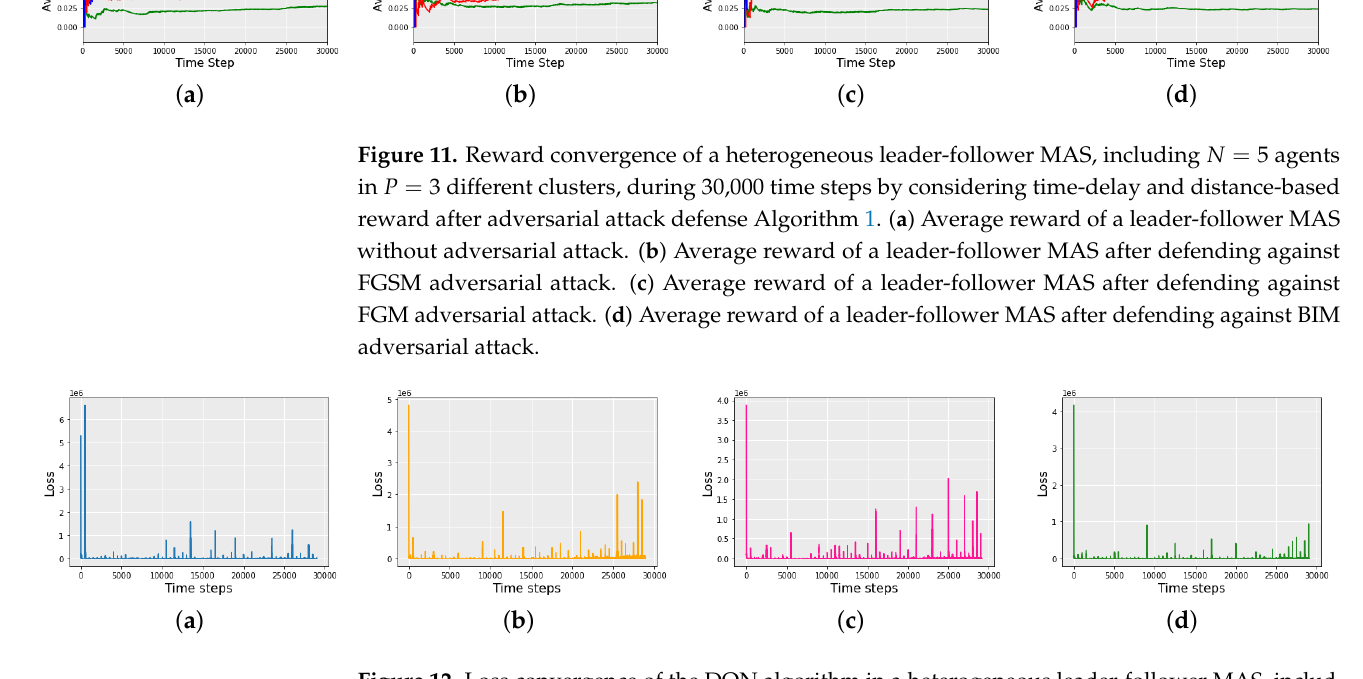
Figure 12. Loss convergence of the DQN algorithm in a heterogeneous leader-follower MAS, includ- ing N = 5 agents in P = 3 different clusters, during 30,000 timesteps by considering time-delay and distance-based reward after adversarial attack defense Algorithm 1. ( a ) DQN average loss in a leader-follower MAS without adversarial attack. ( b ) DQN average loss in a leader-follower MAS after defending against FGSM adversarial attack. ( c ) DQN average loss in a leader-follower MAS after defending against FGM adversarial attack. ( d ) DQN average loss in a leader-follower MAS after defending against BIM adversarial